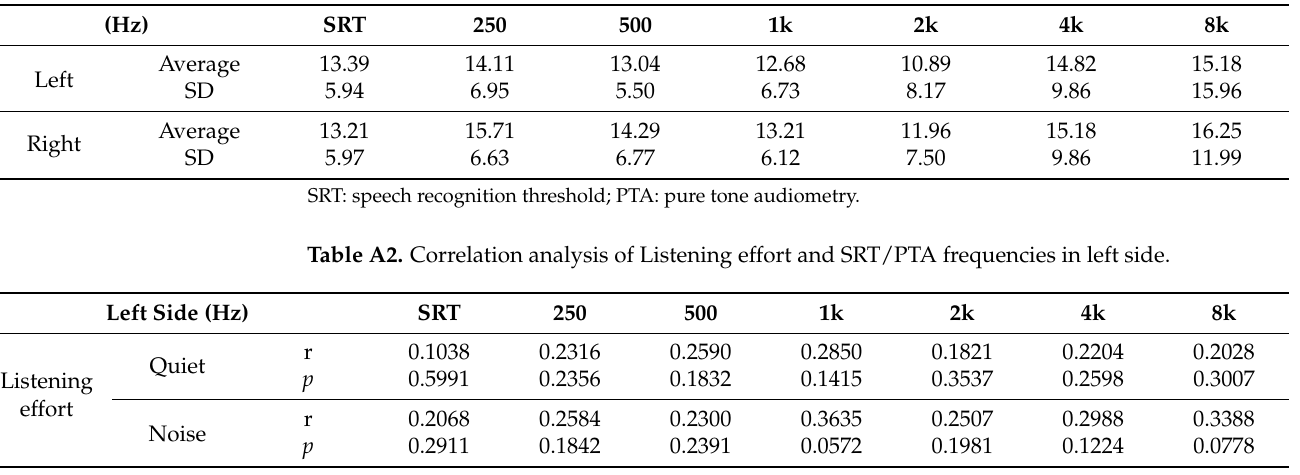
Table A1. Hearing results: the averaged SRT and PTA in each frequency of both sides.